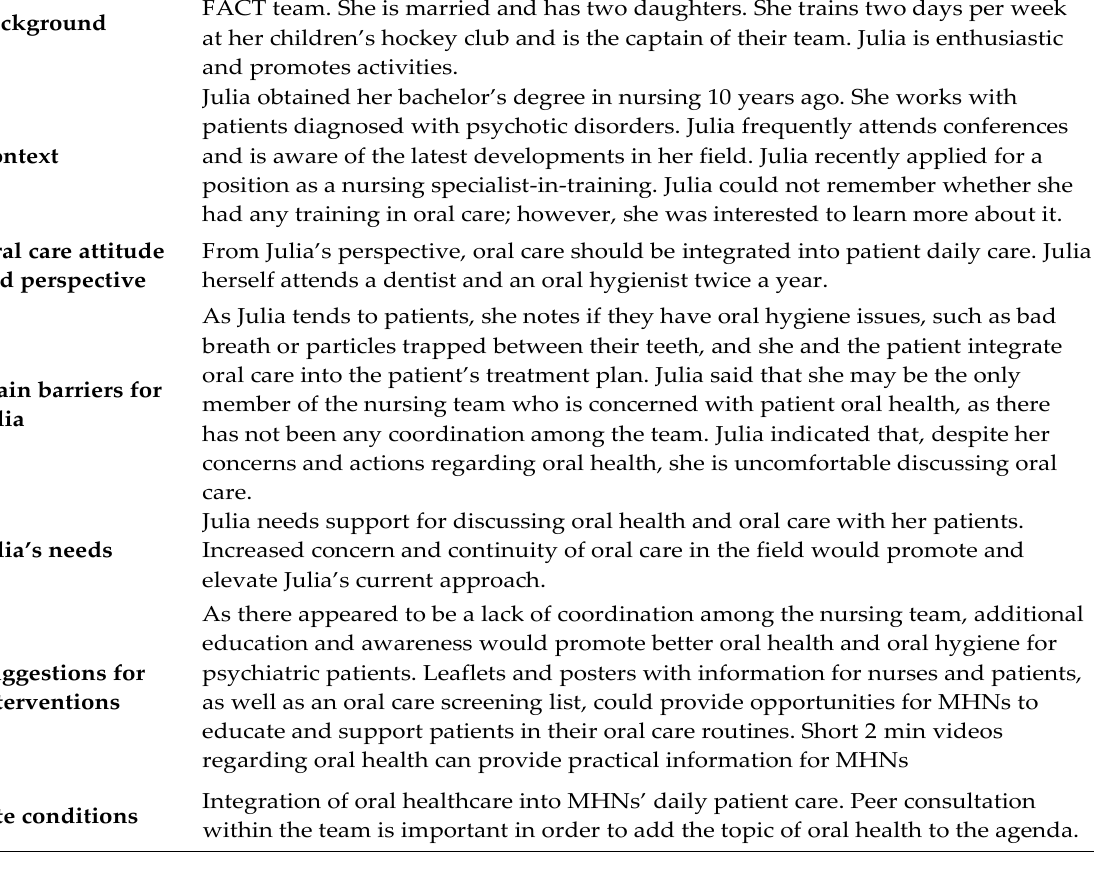
Figure 4. Persona Julia.